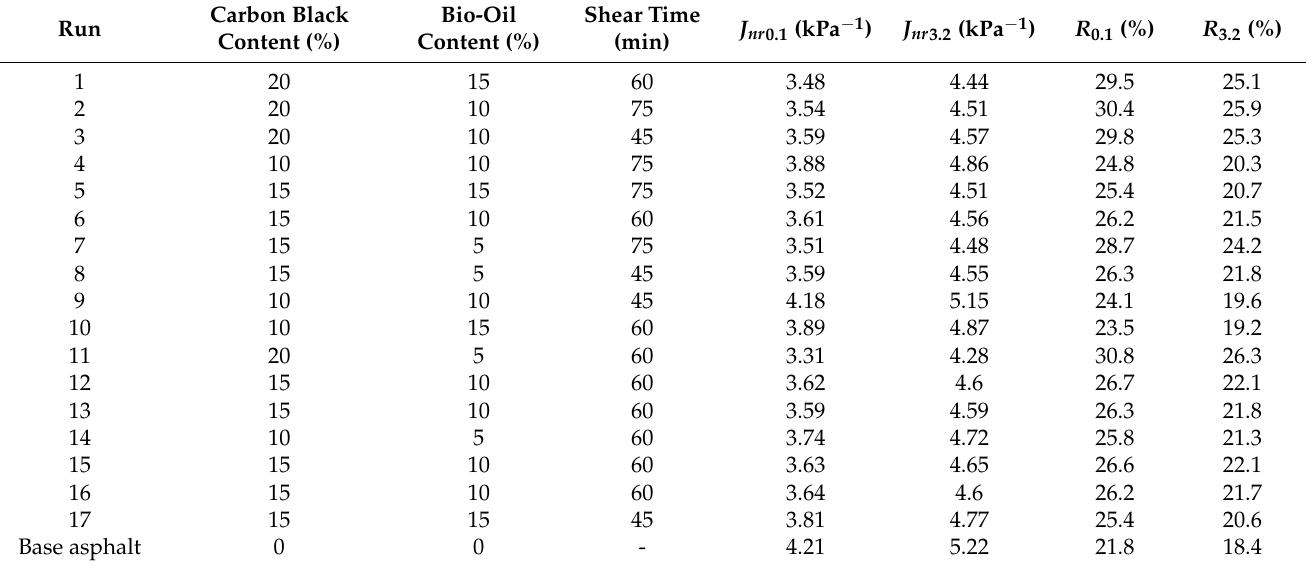
Table 6. MSCR test